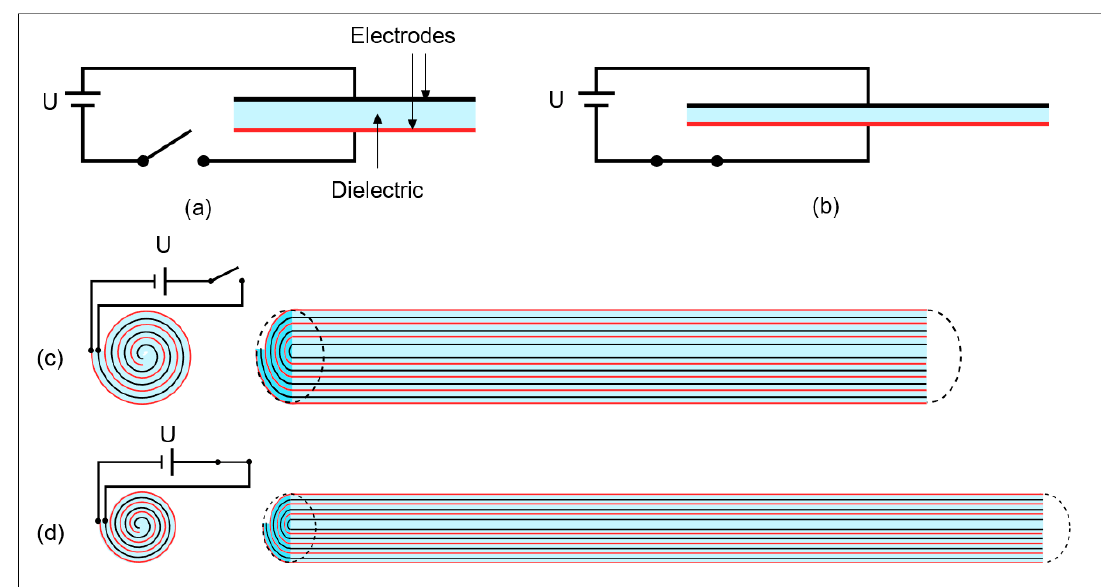
Figure 1. Working principle of a strip-in-plane dielectric elastomer actuator (DEA) and a rolled dielectric elastomer actuator (RDEA), both without applied voltage ( a , c ) and with applied voltage ( b , d ). The views of the RDEA depicted in ( c , d ) are based on a radial cut on the left, and on a longitudinal cut on the right.